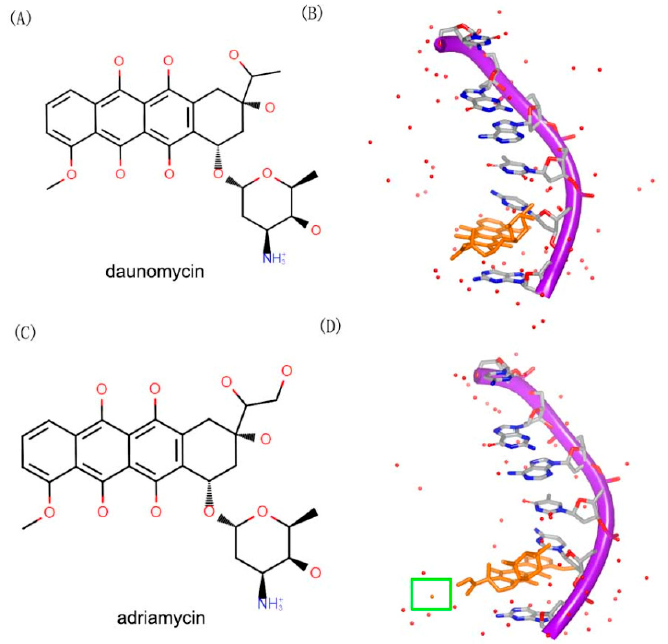
Figure 12. ( A ) Chemical structure of daunomycin; ( B ) one strand of a DNA duplex complex with daunomycin (PDB code: 1D10); ( C ) chemical structure of adriamycin; and ( D ) one strand of a DNA duplex complex with adriamycin (PDB code: 1D12). The orange structure represents the small molecule; the purple structure represents the backbone of nucleic acid; the red dots represent the water molecules; the blue and red atoms in the molecule represent nitrogen and oxygen atoms, respectively. The green square represents the water molecule that interacts with the small molecule.